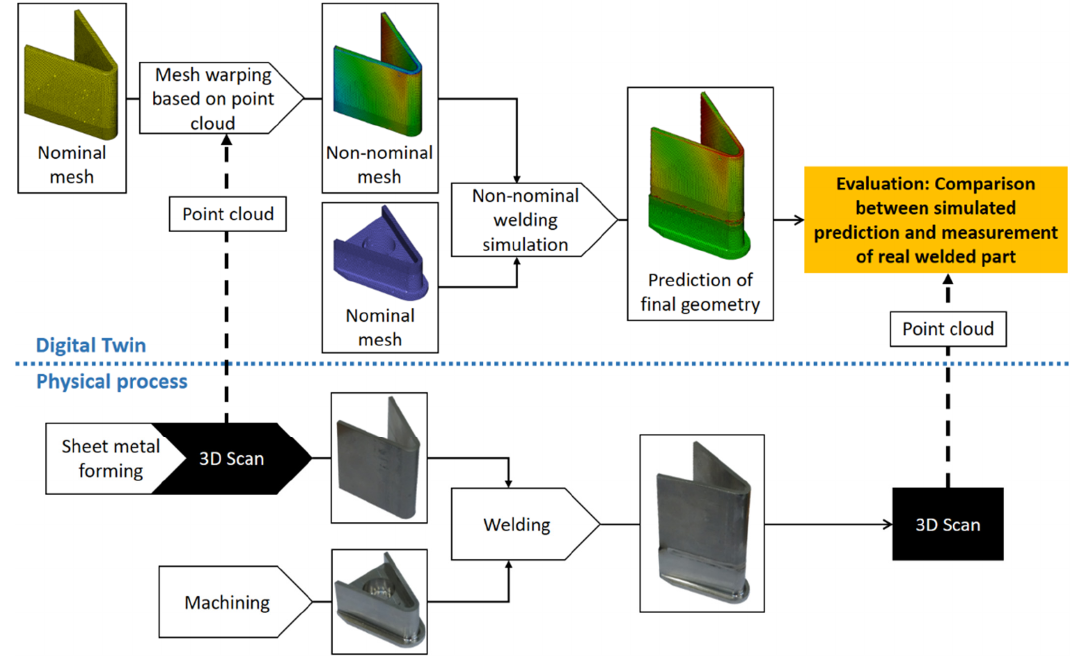
Figure 7. The measurement data from the 3D scan is transferred to the digital twin where it is used in a non ‐ nominal welding simulation. The result from the simulation is compared to a 3D scan of the welded